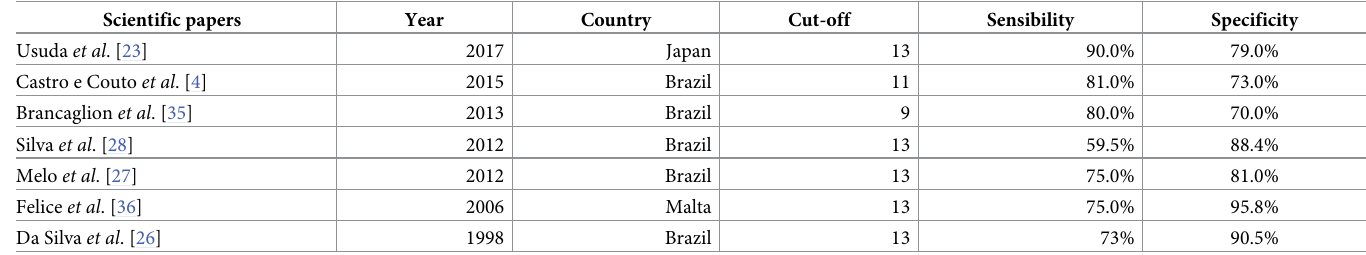
Table 4. EPDS sensibility and specificity in the